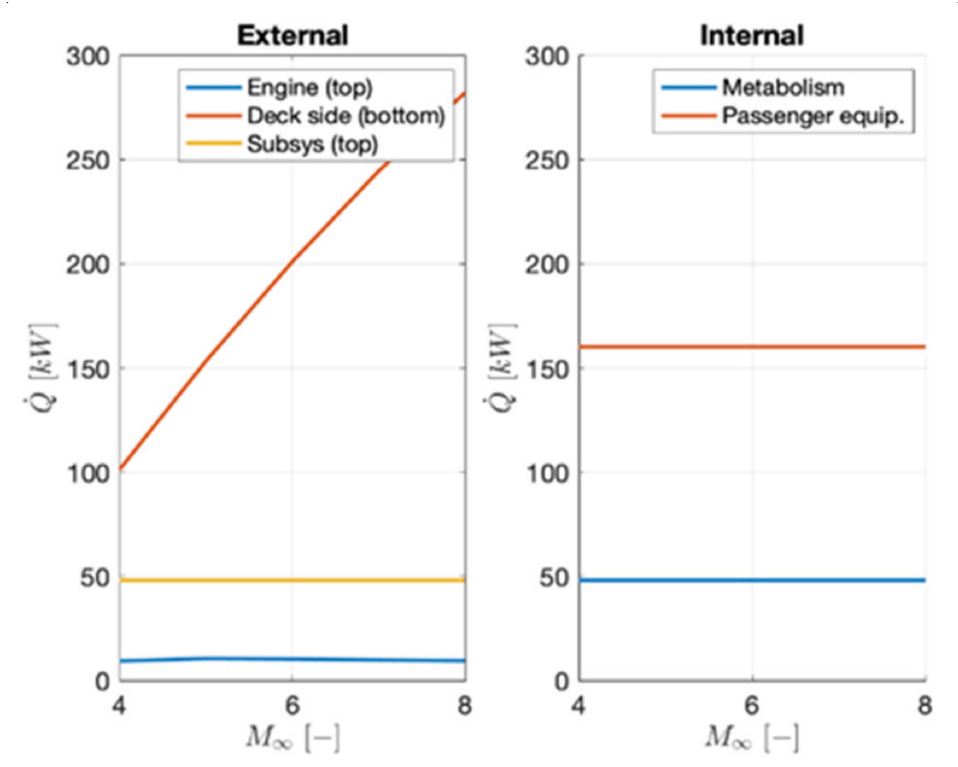
Figure 16. Variation of different types of heat loads for the aircraft with the Mach number for the fixed values of thickness and speed of the boil-off hydrogen insulation layer.